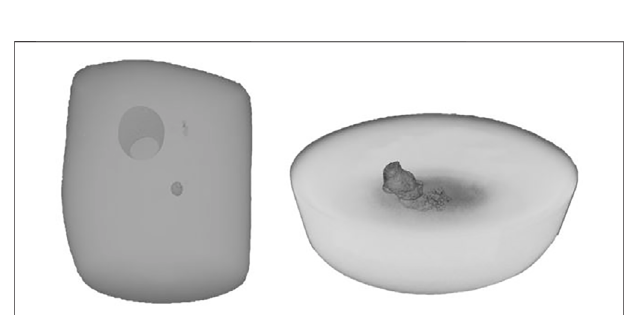
FIGURE 6 | Two 3D XCT scans of a fast heated sample showing the inclusion within the steel matrix.